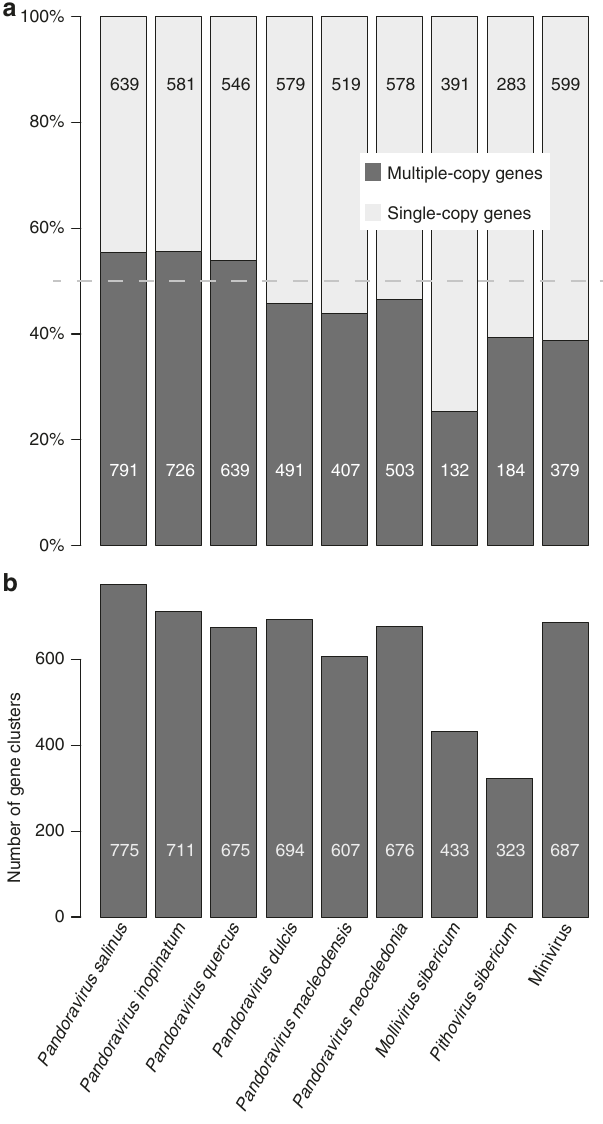
Fig. 6 Analysis of gene duplication in various giant virus families. a Distribution of single-copy versus multiple-copy genes in giant viruses. b Number of distinct gene